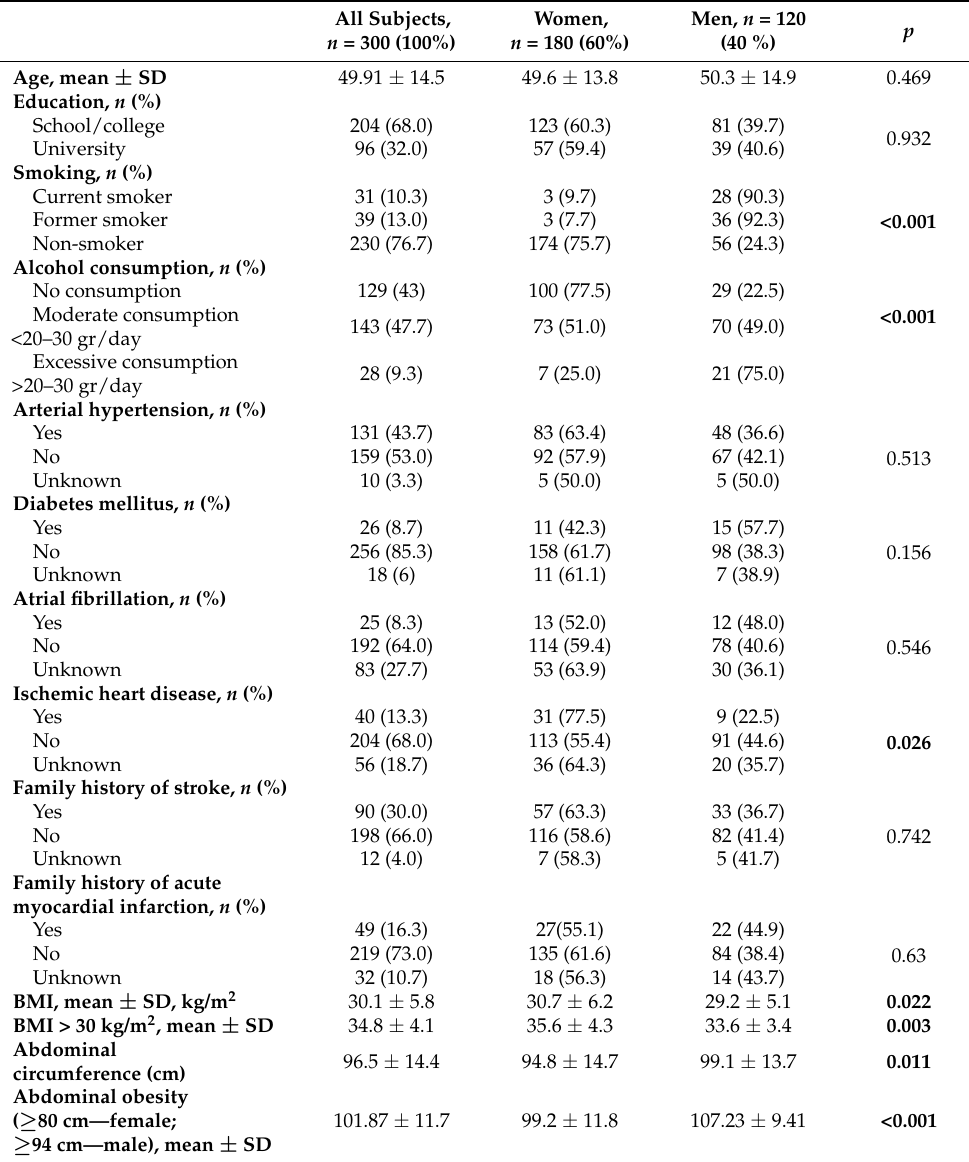
Table 1. Demographic, clinical, and prevalence characteristics of the study